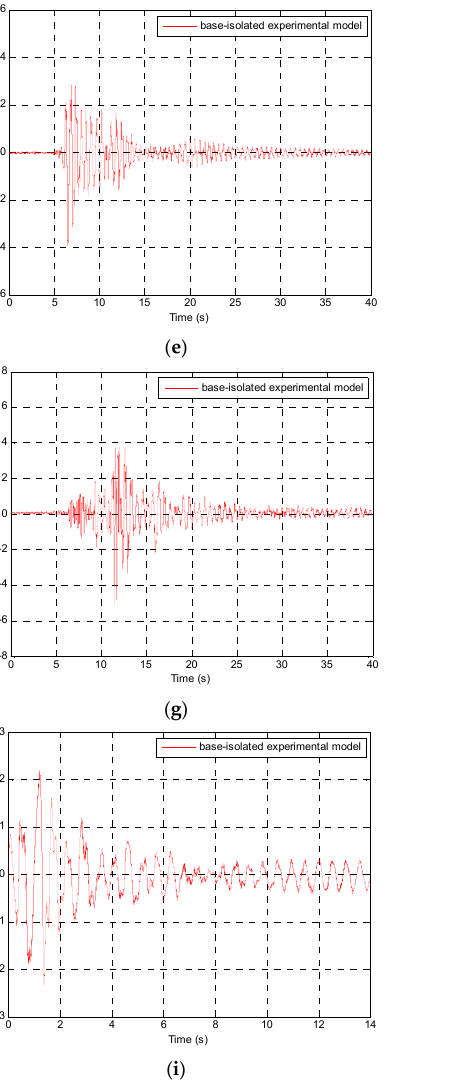
Figure 8. Experimentally determined ( left ) and numerically obtained ( right ) time-acceleration history plots for the base-isolated two-storey model during different ground motions: the 1940 El Centro earthquake ( a , b ), the 1971 San Fernando earthquake ( c , d ), the 1989 Loma Prieta earthquake ( e , f ), the 1994 Northridge earthquake ( g , h ), and the 2002 Polkowice mining tremor ( i , j ). As indicated by Figures 5–8 and Tables 2 and 3, the results of the numerical analysis explicitly confirm high effectiveness of the developed mathematical model in simulating complex hysteretic behaviour of the prototype base isolation system made of PBs. Close inspection of Tables 2 and 3 demonstrates that the reduction levels in peak lateral accelerations, which were calculated based on both numerical results and previously obtained experimental data (see [28]), are very similar for every ground motion analyzed. In the case of the base-isolated single-storey model, the largest difference between numerical and experimental peak lateral acceleration has been obtained for the 1971 San Fernando earthquake (difference of 7.74%), while the lowest one for the 2002 Polkowice mining tremor (difference of 0.46%). On the other hand, in the case of the base-isolated two-storey model, the largest difference between numerical and experimental peak lateral acceleration has been